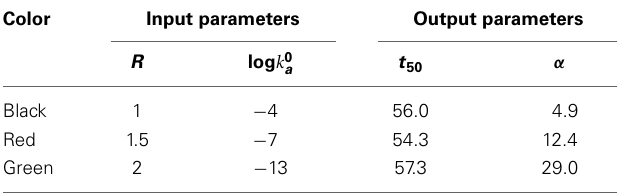
Table 2 | Input and output parameters characterizing each simulation, calculated using the condensation model, plotted in Figures 2A,B.